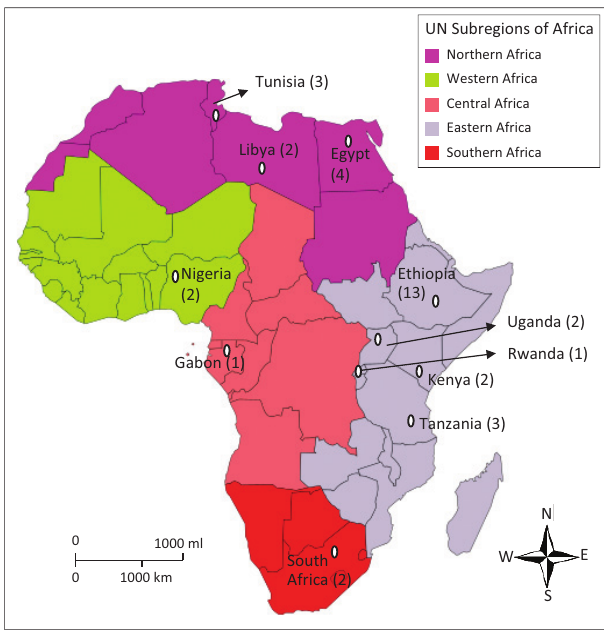
FIGURE 3: Distribution and number of eligible published articles on healthcare- associated infections in different African